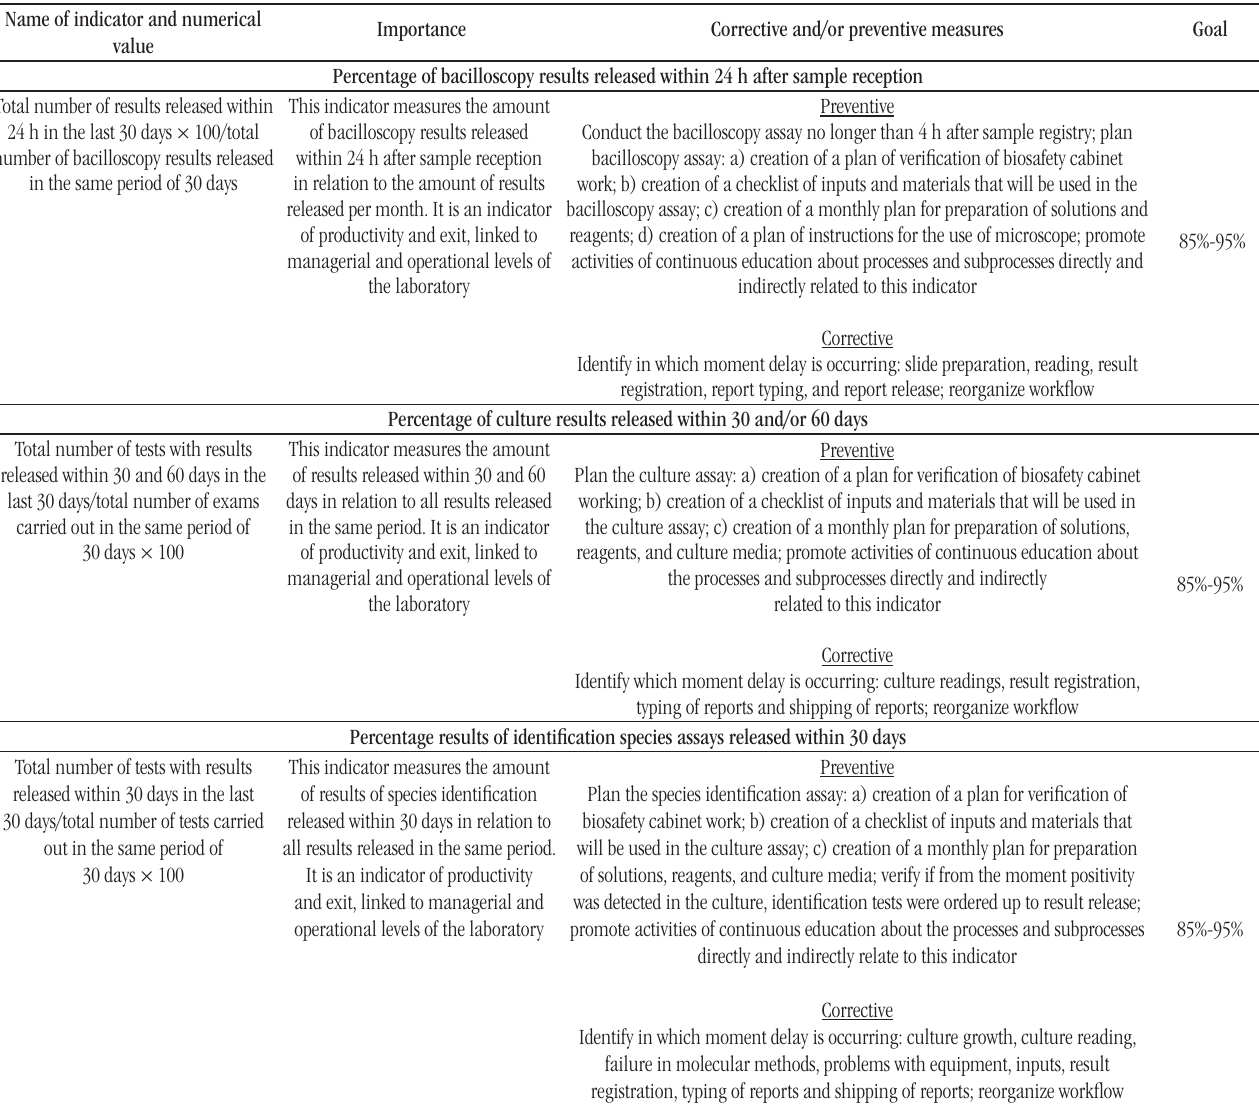
taBLE 2 − Definition and description of efficacy indicators of result release